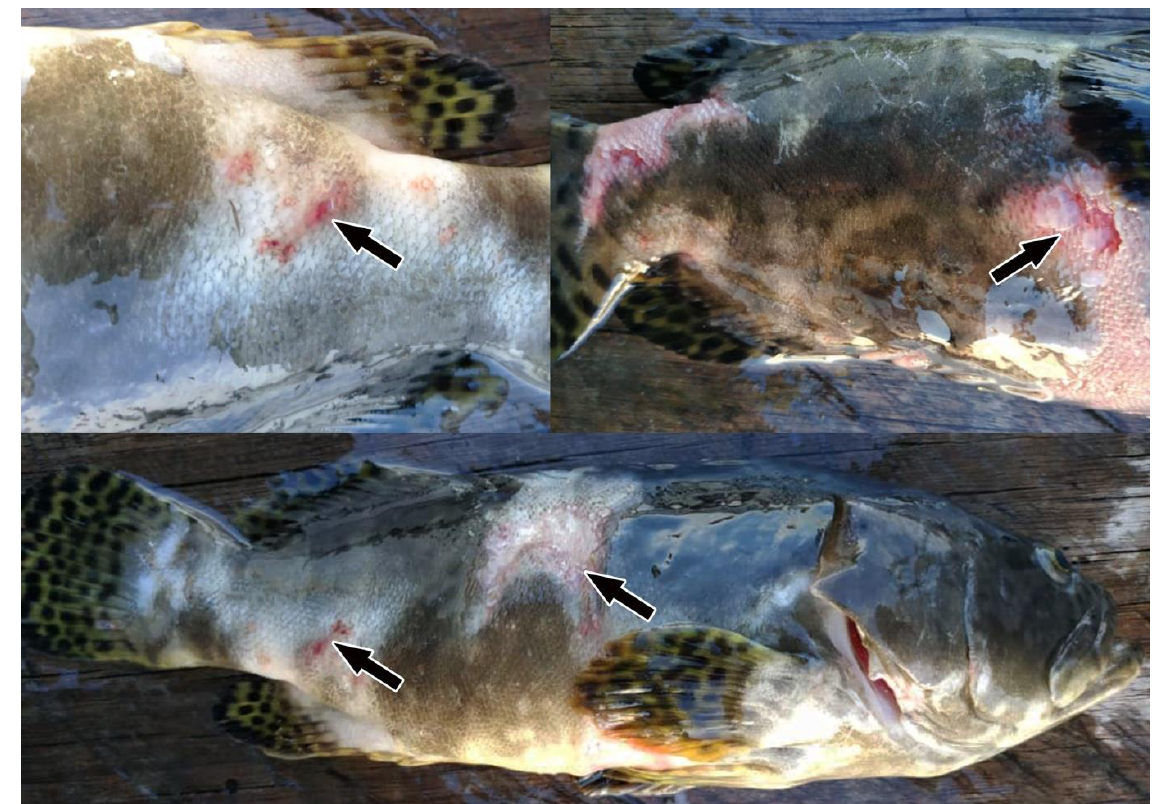
Figure 7. Percentage of survival between control and vaccinated group throughout the 112-day vac- cination period. * Indicates a significant difference ( p < 0.05 ) between the vaccinated and control groups.